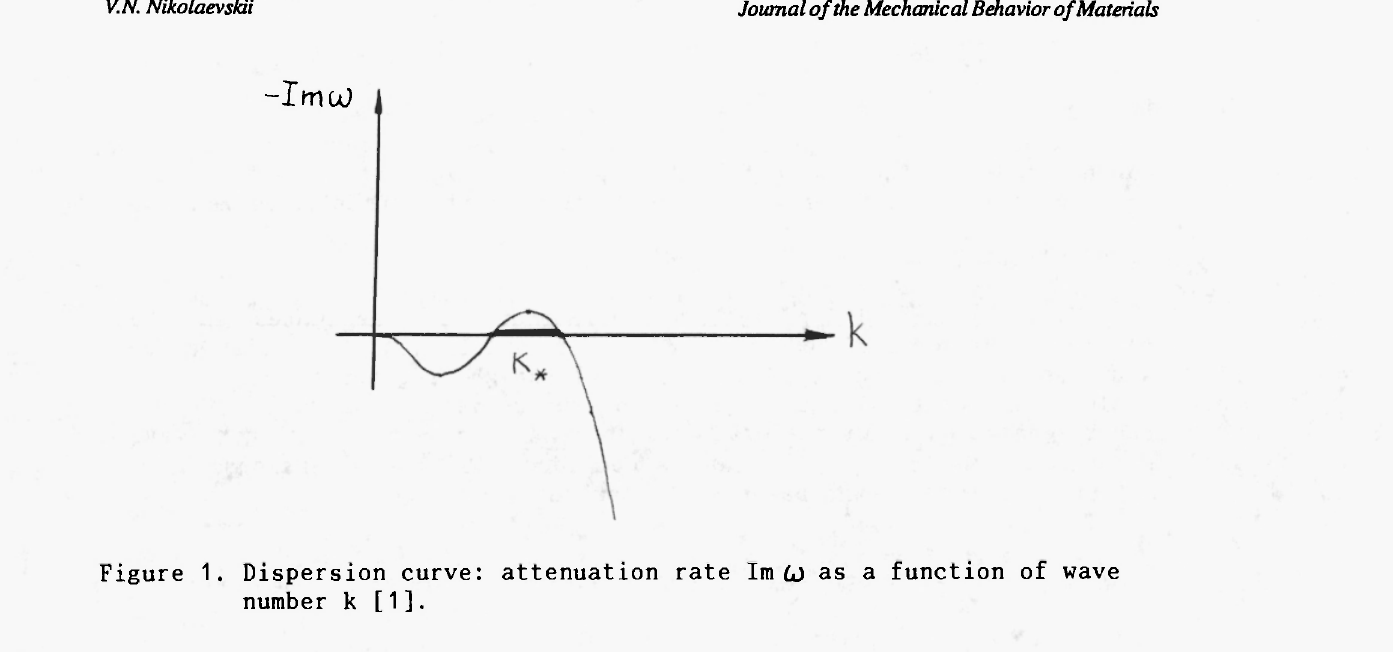
Figure 1. Dispersion curve: attenuation rate Im ίο as a function of wave number k [1